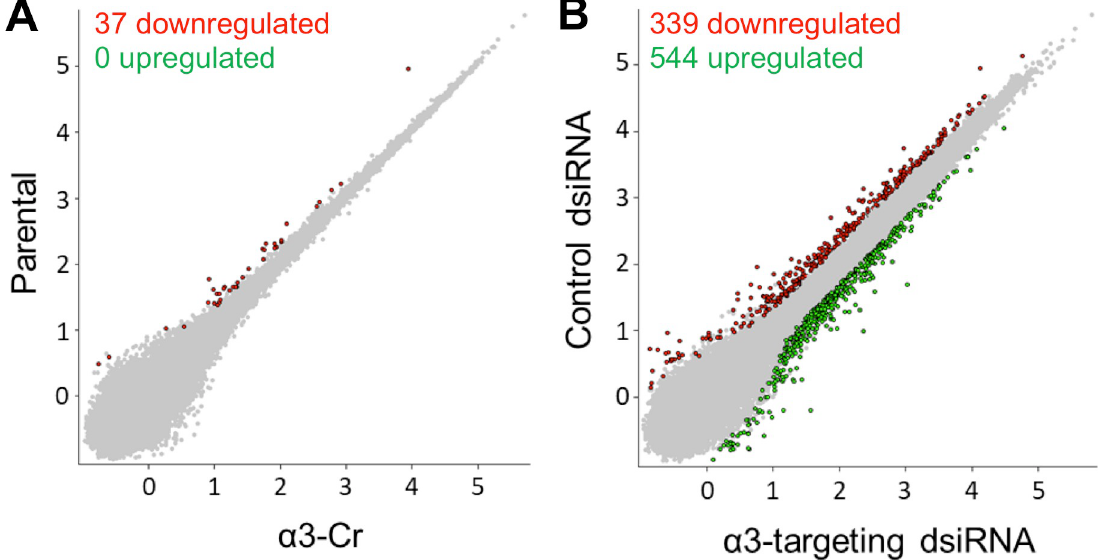
Fig 3. CRISPR-targeting and RNAi-targeting of the ITGA3 gene have distinct effects on the MDA-MB-231 cell transcriptome. Scatterplots (relative gene expression, log 10 scale) show pairwise comparisons of RNA-seq data from (A) parental MBA-MB-231 cells vs. CRISPR-generated α 3-Cr cells, or from (B) MBA-MB-231 cells treated with control dsiRNA vs. α 3-targeting dsiRNA. The number of genes that were down-regulated (red) or up-regulated (green) in ITGA3-targeted cells, from a total of 37,671 discovered genes, is indicated. False discovery rate (FDR) < 0.05; fold-change > 2.0.